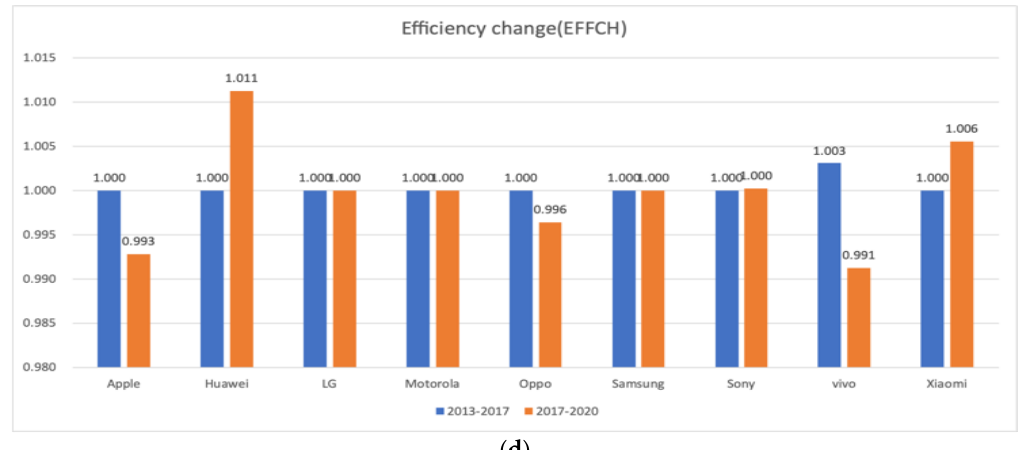
Figure 3. Comparison of productivity changes by period using global MPI: ( a ) transition of technology change and efficiency change. The figure is displayed in the form of “Company name year, efficiency change, technological change”. For example, “Samsung1317, 1.0, 1.1” means “Samsung’s average efficiency change from 2013 to 2017 is 1.0, and technological change is 1.1”; ( b ) productivity